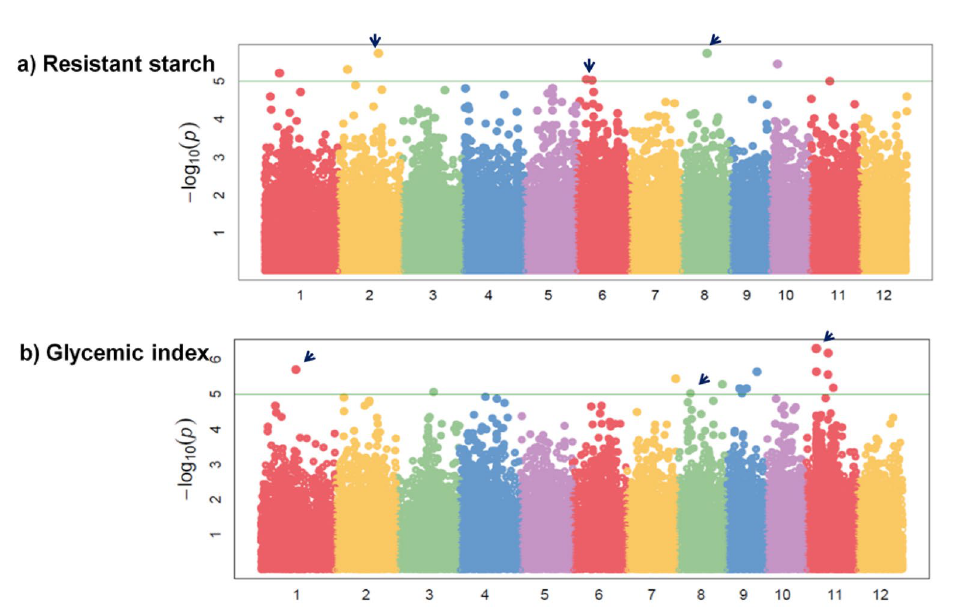
Figure 3. Genome wide association studies—Manhattan plot showing peak associations for resistant starch and predicted glycemic index in ( a ) Peak association for resistant starch on chromosome 2, 6 and 8 in transplanted rice, ( b ) Peak association for PGI on chromosome 1, 8 and 11 in transplanted